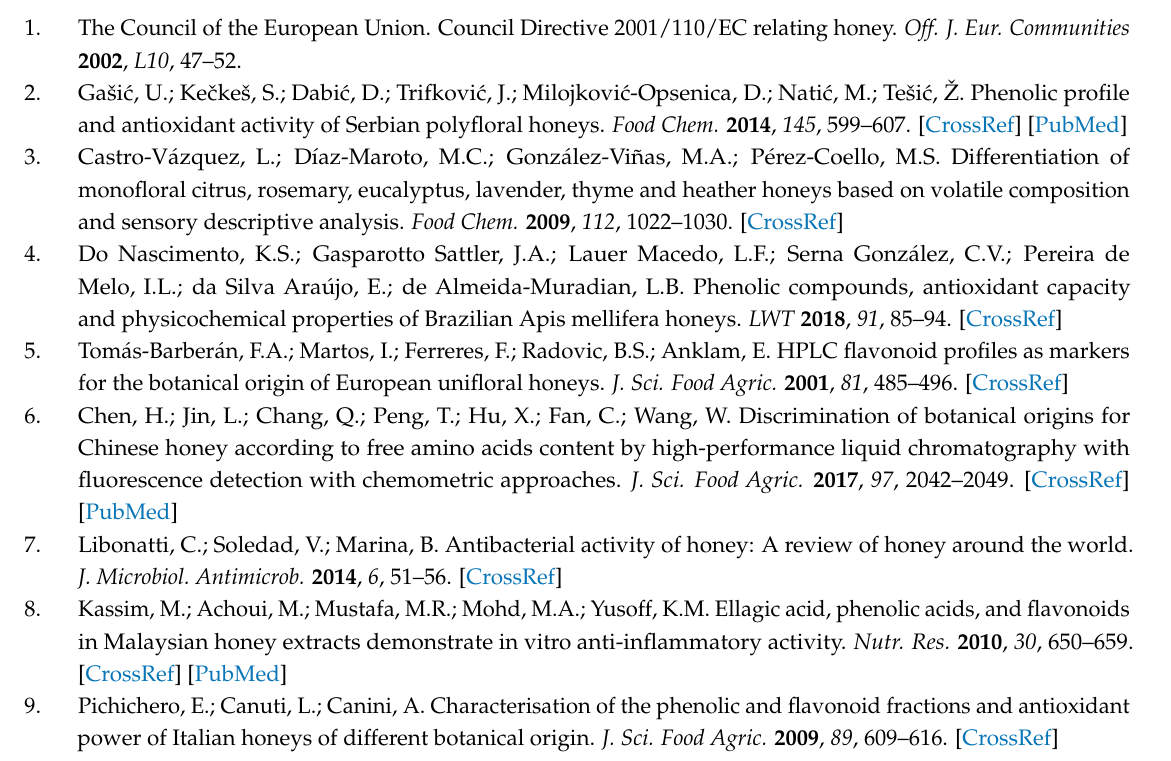
s1, Figure S1: Chromatograms of analyzed compounds, Figure S2: OPLS-DA score plot between acacia versus the rest, Figure S3: OPLS-DA score plot between vitex versus the rest, Figure S4: OPLS-DA score plot between linden versus the rest, Figure S5: OPLS-DA score plot between rapeseed versus the rest, Figure S6: OPLS-DA score plot between astragalus versus the rest, Figure S7: OPLS-DA score plot between codonopsis versus the rest, Table S1: Content of phenolic and flavonoid compounds in acacia honey samples (ng g − 1 ), Table S2: Content of phenolic and flavonoid compounds in vitex honey samples (ng g − 1 ), Table S3: Content of phenolic and flavonoid compounds in linden honey samples (ng g − 1 ), Table S4: Content of phenolic and flavonoid compounds in rapeseed, astragalus and codonopsis honey samples (ng g − 1